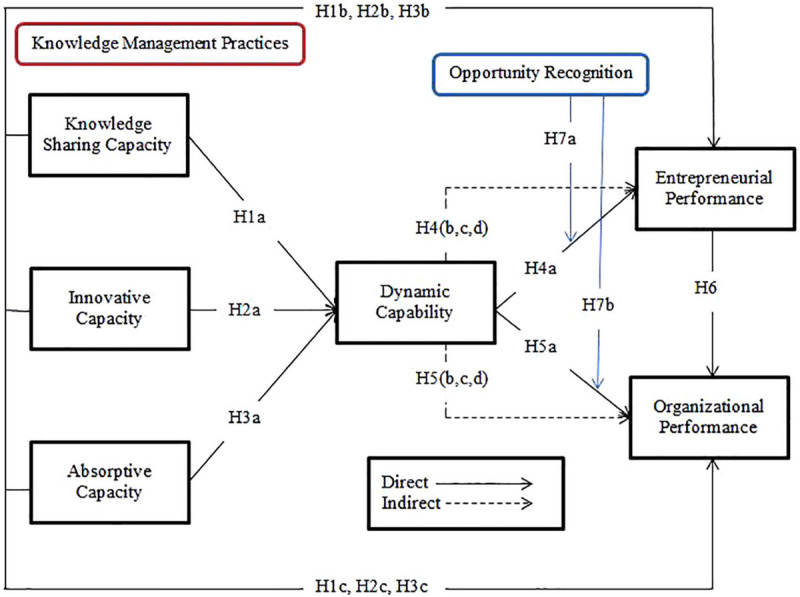
Conceptual model.